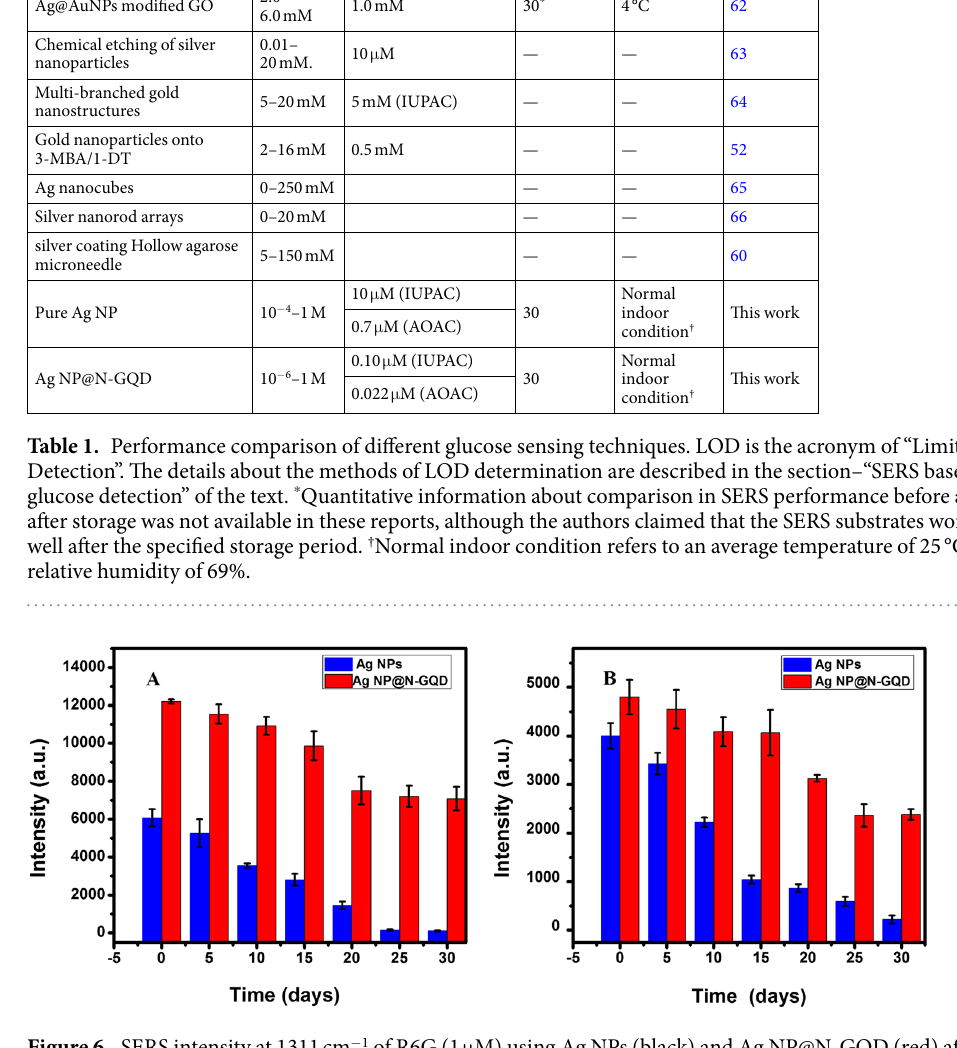
Figure 6. SERS intensity at 1311 cm − 1 of R6G (1 μ M) using Ag NPs (black) and Ag NP@N-GQD (red) after the NPs were stored ( A ) in solution and ( B ) in the dried form, for different numbers of days recorded over 30 days, respectively. Each data point represents the average value from five SERS spectra measured from different locations. Error bars indicate the standard